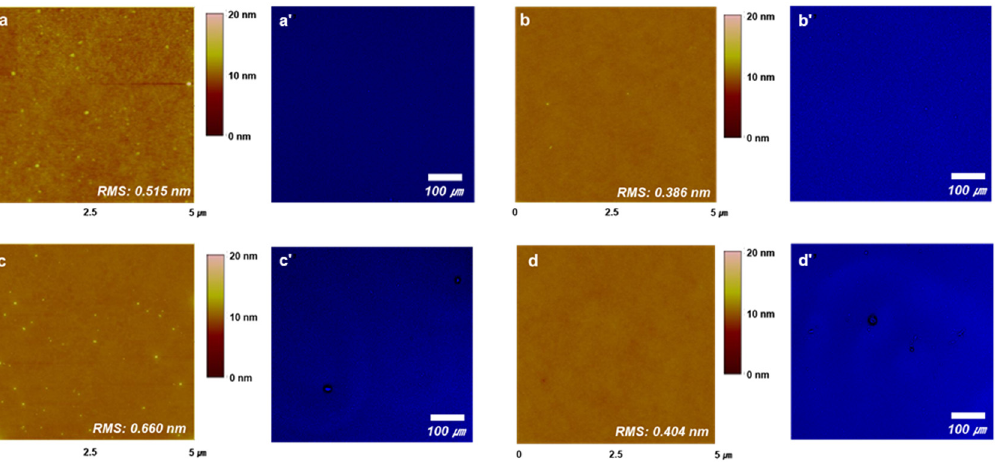
Figure 3. The AFM and confocal images of ( a , a ′ , c , c ′ ) TDBA-BCZ and ( b , b ′ , d , d ′ ) TDBA-PCZ in the doped ( top row ) and nondoped ( bottom row )-film states.